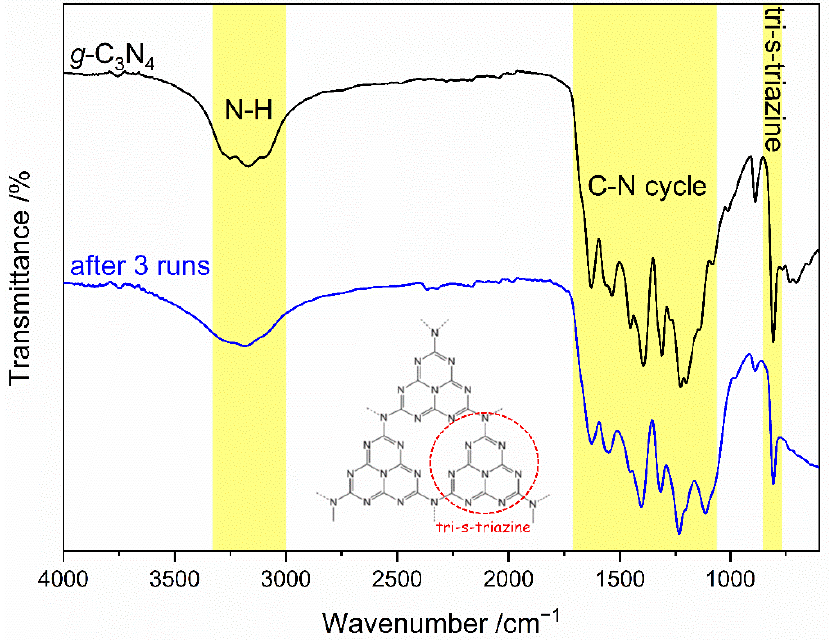
Figure 5. FTIR patterns of g -C 3 N 4 .